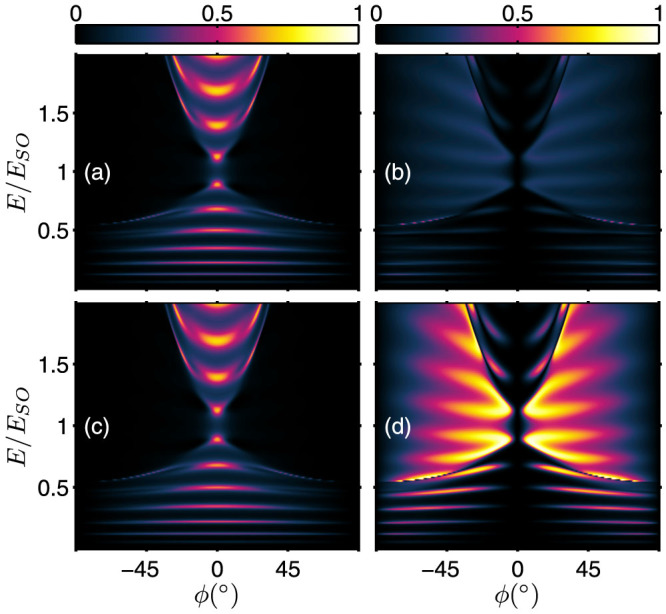
Energy spectrum of the transmission probabilities in the presence of asymmetrical interface scattering potential, ZL ≠ ZR.(a) ; and (b)  for ZL = 0.5 and ZR = 1.5; (c) ; and (d)  for ZL = 1.5 and ZR = 0.5. (The junction tunneling parameters are the same as Figure 4)